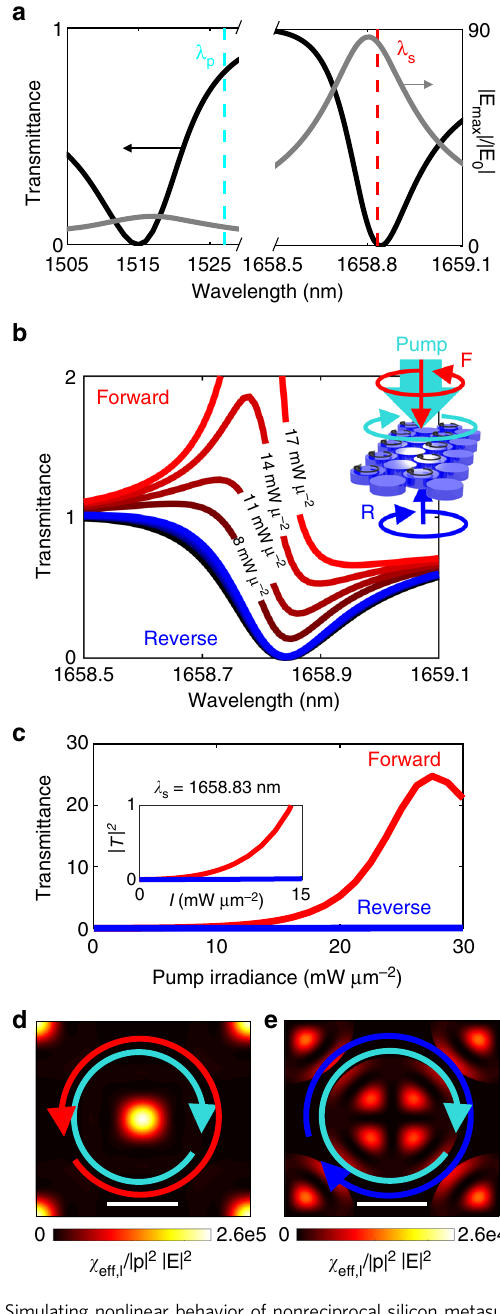
Fig. 3 Simulating nonlinear behavior of nonreciprocal silicon metasurface. a Transmittance and fi eld ampli fi cation spectra close to pump wavelength, indicated by cyan line, and Stokes wavelength, indicated by red line. b Evolution of transmission resonance with increasing pump power from 0.1 to 17mW µ m − 2 . The pump wave is right handed circularly polarized while all signal waves are left handed circularly polarized, with red (blue) curves representing co(counter)-propagating pump and probe waves. c Metasurface transmittance for forward and reverse signal propagation directions as a function of pump irradiance. Inset shows zoom-in of low power behavior. d and e Spatial distributions of local contributions to normalized effective Raman susceptibility for d co-propagating pump and probe waves, and e counter-propagating pump and probe waves. Scale bars are 325nm